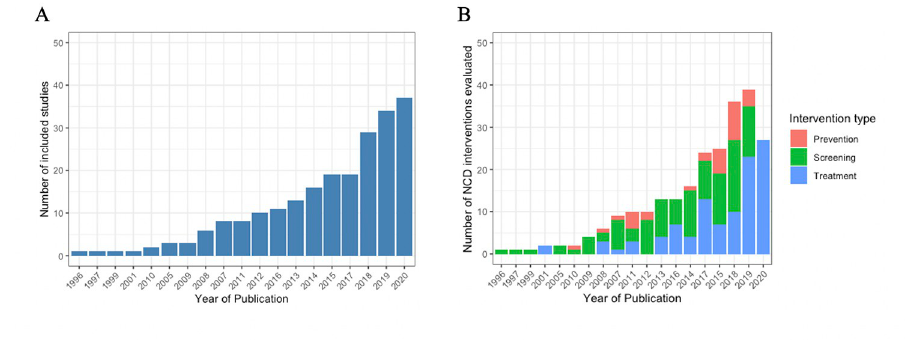
Fig 5. Growth of research over time (A) and distributions of NCD interventions by type (B). Fig 5A shows number of studies published each year ( N = 222 studies); Fig 5B shows distributions by type of interventions ( N = 265 NCD interventions evaluated in studied included in the